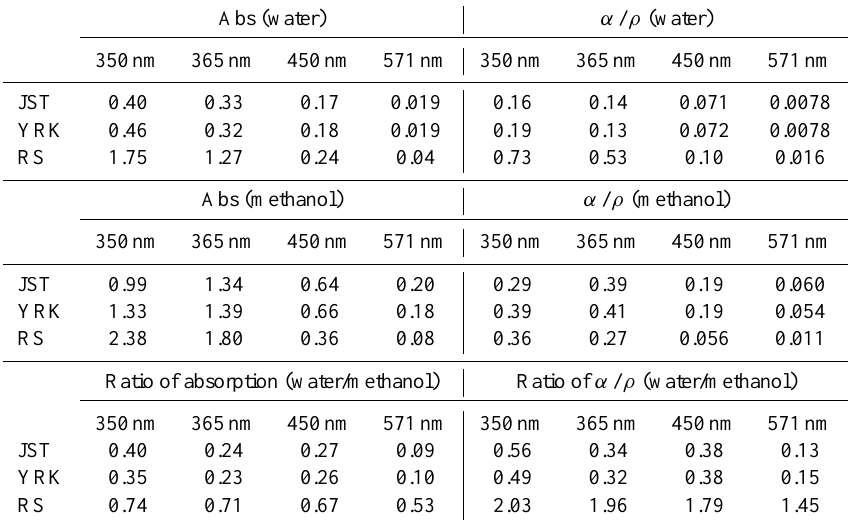
Table 3. Values of absorption, absorption per mass α / ρ (normalized by WSOC for water extracts and OC for methanol extracts) and the ratio between water and methanol extracts for samples collected at JST (urban), YRK (rural) and RS (road-side). Data are averages for all stages 3.1µm and below, plus the after filter. Unit of absorption (Abs) is Mm − 1 , and for α / ρ the unit is m 2 g − 1 (see Eq.